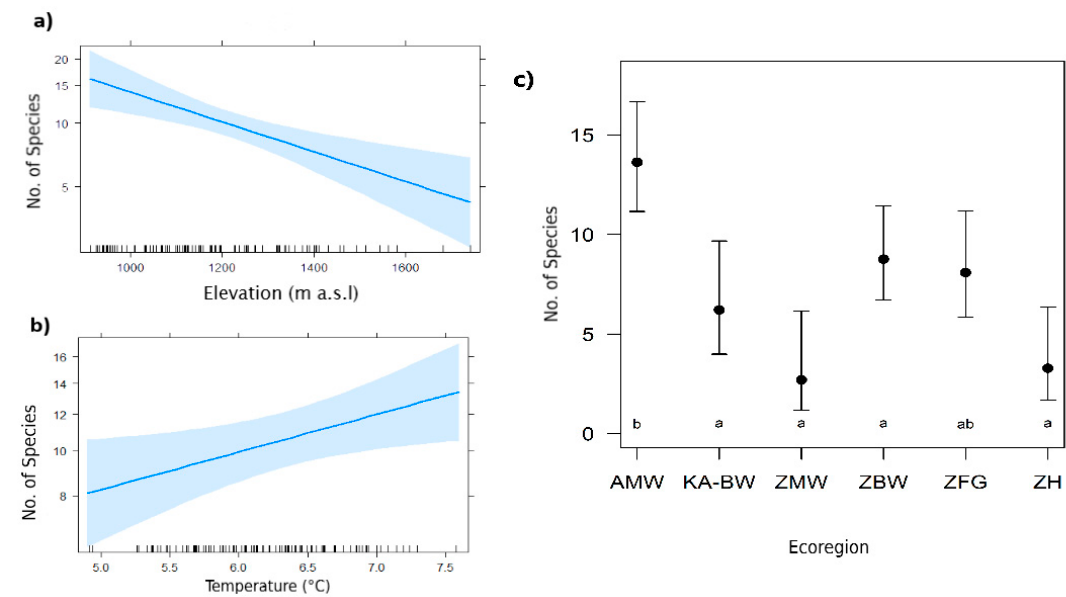
Figure 2. Recorded number of bat species in response to ( a ) elevation, ( b ) minimum temperature and ( c ) terrestrial ecoregion (different annotated letters showing a significant difference in species richness). AMW = Angolan Miombo woodland; KA-BW = Kalahari Acacia-Baikiaea woodlands; ZMW = Zambezian and Mopane woodlands; ZBW = Zambezian Baikiaea woodlands; ZFG = Zambezian flooded grasslands; ZH = Zambezian halophytics.